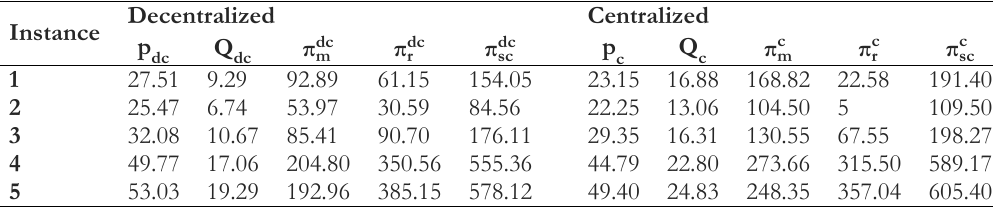
Table 2. The quantity of economic order, product prices, and profits of firms in pre-contract centralized and decentralized